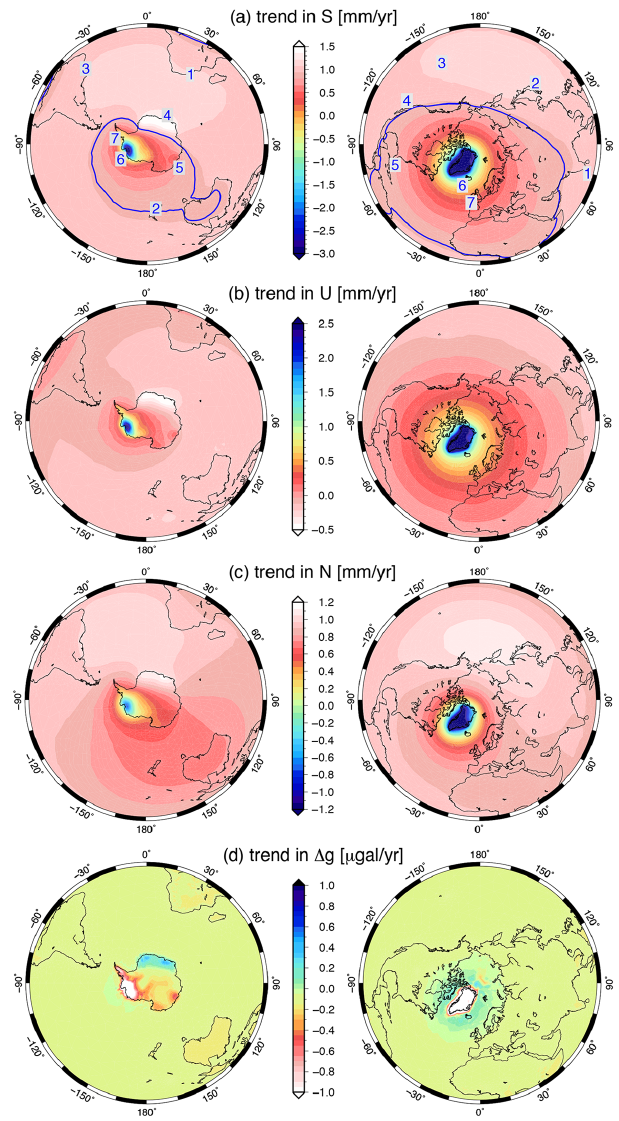
Figure 4. Some important geodetic signatures of ice sheets dur- ing the GRACE period. Rates of change in (a) relative sea level, (b) solid-earth deformation, (c) absolute sea level, and (d) abso- lute gravity. (Notice the different scale and color order in the color bars.) These results are obtained by linearly fitting the correspond- ing monthly solutions in a least-square sense. The blue contours in (a) represent the trend in the global mean value, with magnitude d S/ d t = 0 . 91mmyr − 1 . Annotations are supplied for 14 locations in (a) (see Table 3 for their